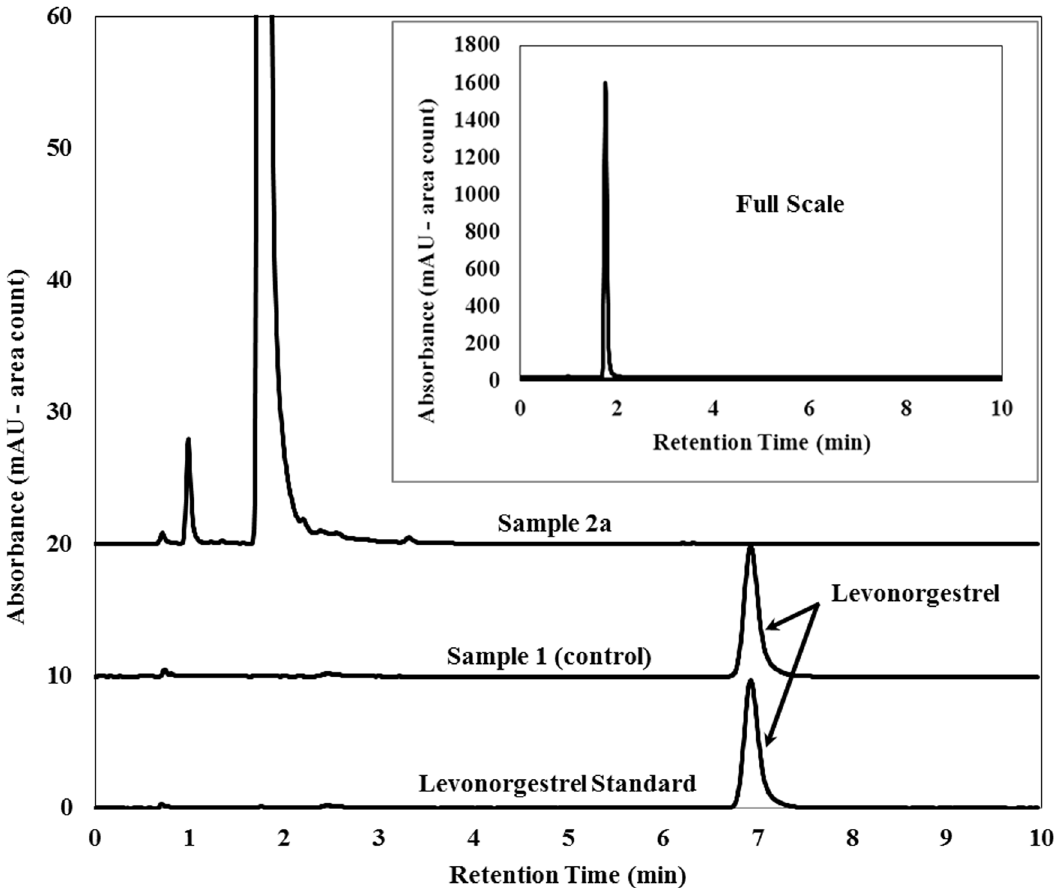
Figure 2. HPLC-DAD analysis. HPLC chromatograms from assay / content uniformity analysis for a levonorgestrel standard, sample 1 (positive control), and sample